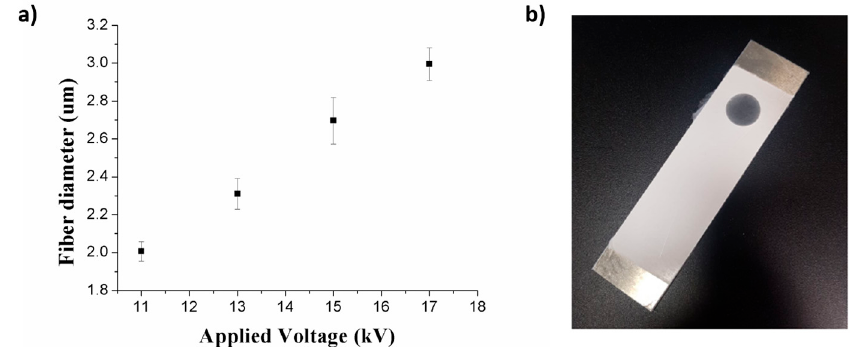
Figure 1. ( a ) Evolution of the fiber diameter as a function of the applied voltage (11, 13, 15, and 17 kV) at a fixed flow rate of 1.5 mL / h; ( b ) Aspect of the electrospun coating based on the deposition of PS electrospun fibers with a characteristic white coloration onto an aluminum reference substrate.